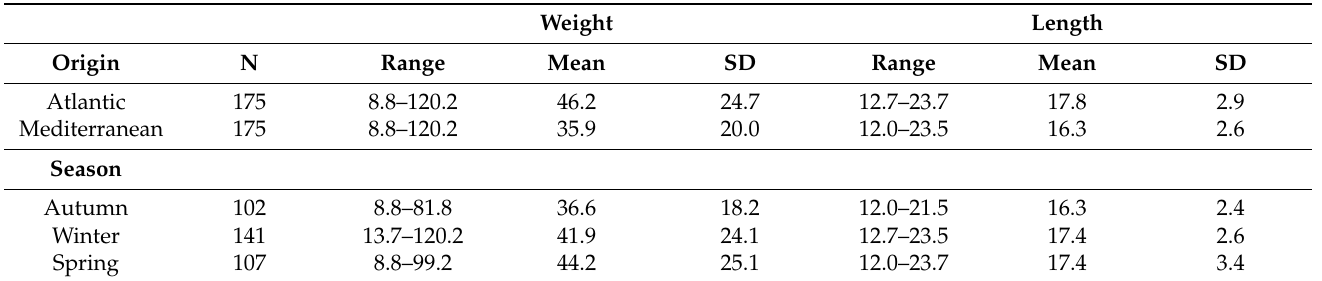
Table 1. Number (N) of sardines analyzed and their characterization by weight (g) and length (cm)—range, mean and standard deviation (SD)—by origin and season of